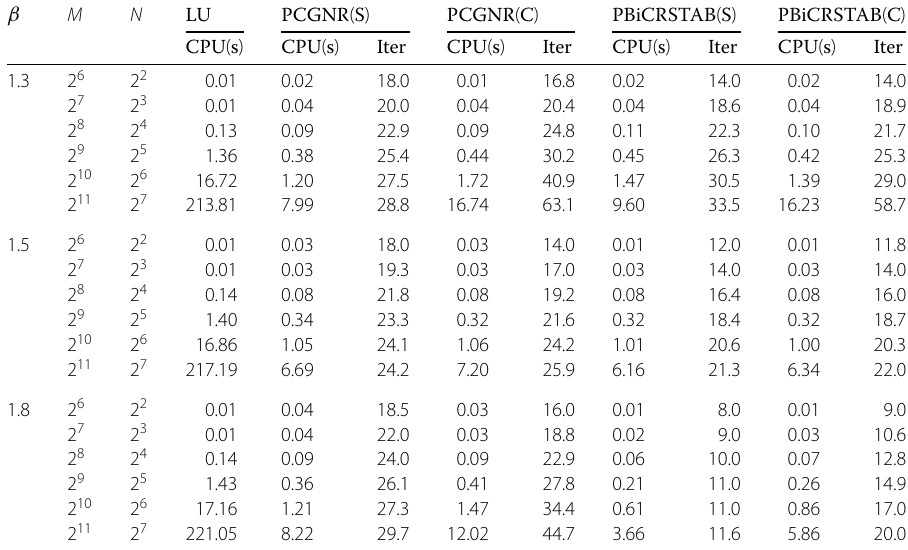
Table 3 Comparisons for solving Example 5.1 by the LU method and the PCGNR/PBiCRSTAB method with two circulant preconditioners, where β = 1.3,1.5,1.8, α = 0.5, q = 10, and T = 0.75 β